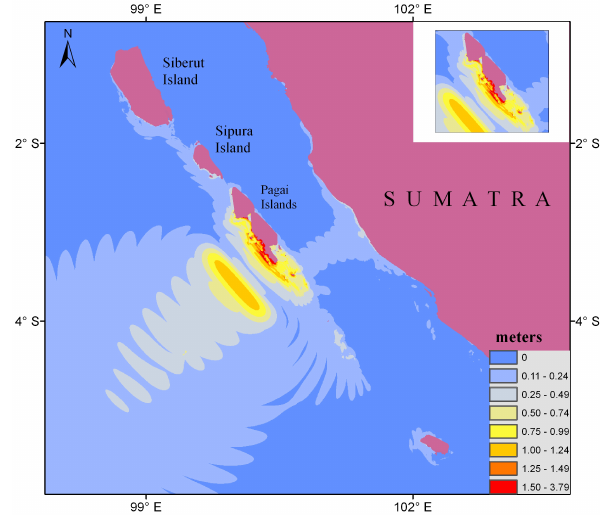
Fig. 14. Maximum computed heights from SWAN model with a cell size of 0.25min.